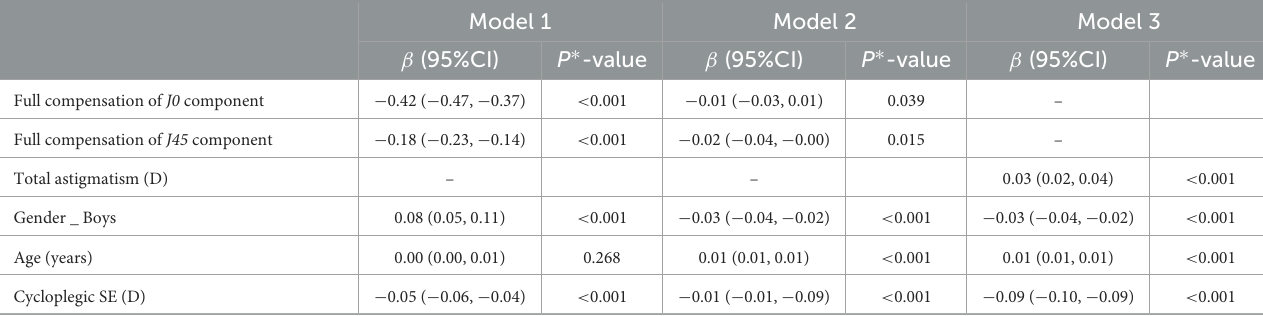
Model1:Totalastigmatismwasthedependentvariable;Model2andModel3:Uncorrecteddistancevisualacuity(LogMARacuity)wasthedependentvariable. P ∗ -ValueswerecalculatedwithamultivariateGeneralizedLinearModeladjustedforage,gender,cycloplegicsphericalequivalence,maternalandparentalrefractivestatus.